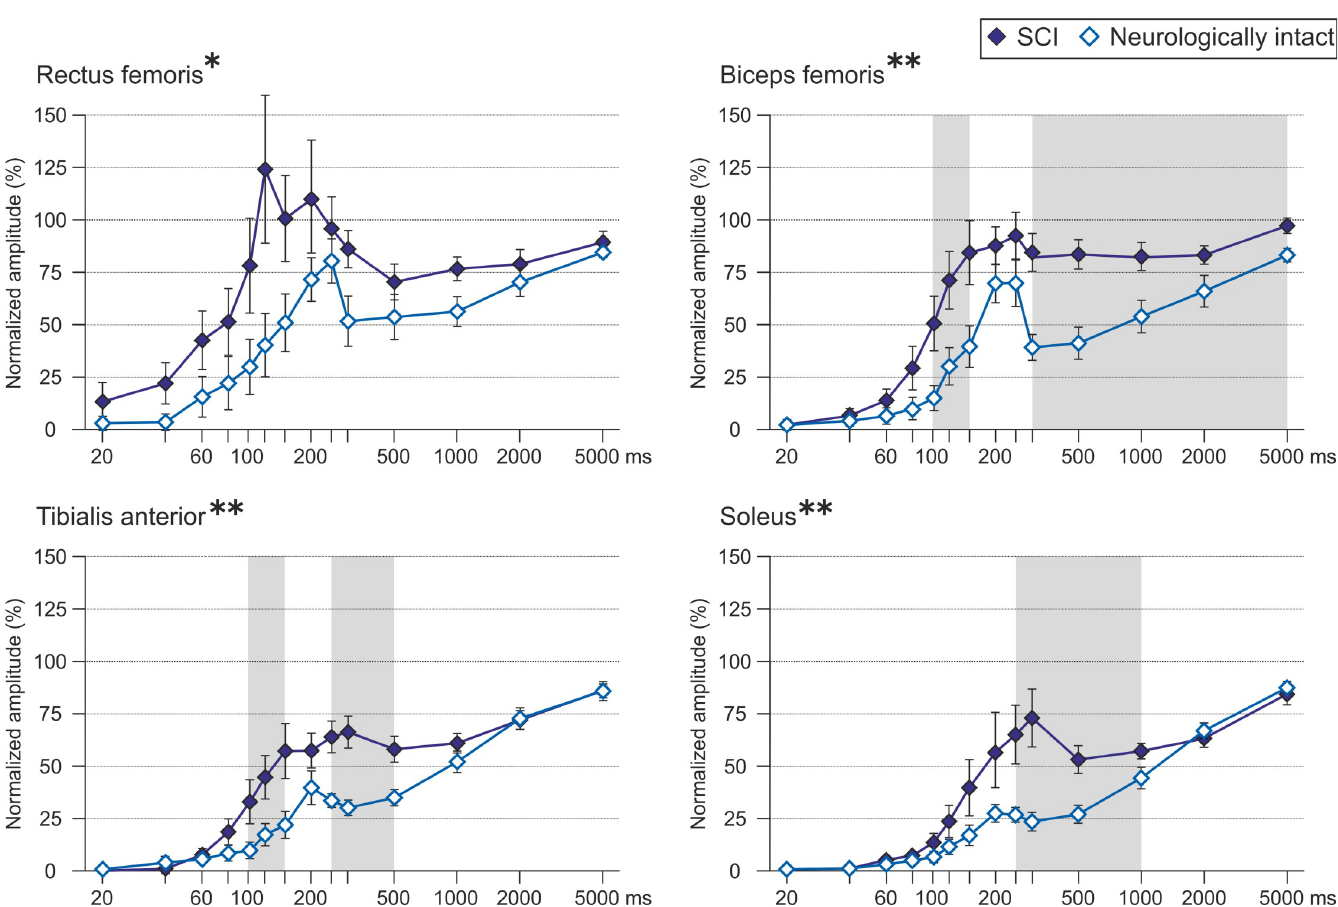
Fig 4. Recovery cycles of PRM reflexes of thigh and lower leg muscles in neurologically intact individuals and individuals with spinal cord injury. Recovery of PRM reflexes of rectus femoris, biceps femoris, tibialis anterior, and soleus for the neurologically intact group (light blue) and the spinal cord injured group (dark blue) with increasing conditioning-test intervals (x-axis, logarithmic scale). The y-values are group means ± SE of the normalized peak-to-peak amplitudes (second to first response) per conditioning-test interval. The PRM reflexes of all muscles studied recovered significantly faster in the individuals with spinal cord injury (significant main effects of neurological status; � , P < .05, �� , P < .01). There were significant interaction effects between neurological status and conditioning-test interval in case of biceps femoris, tibialis anterior, and soleus; shaded backgrounds mark respective conditioning-test intervals with significant differences in PRM reflex recovery between subject groups (Bonferroni-adjusted post-hoc tests; all P <